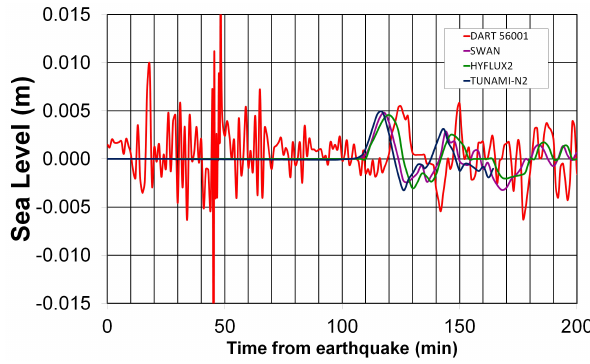
Fig. 19. Time series of sea level elevation from model forecasts for the earthquake compared to DART